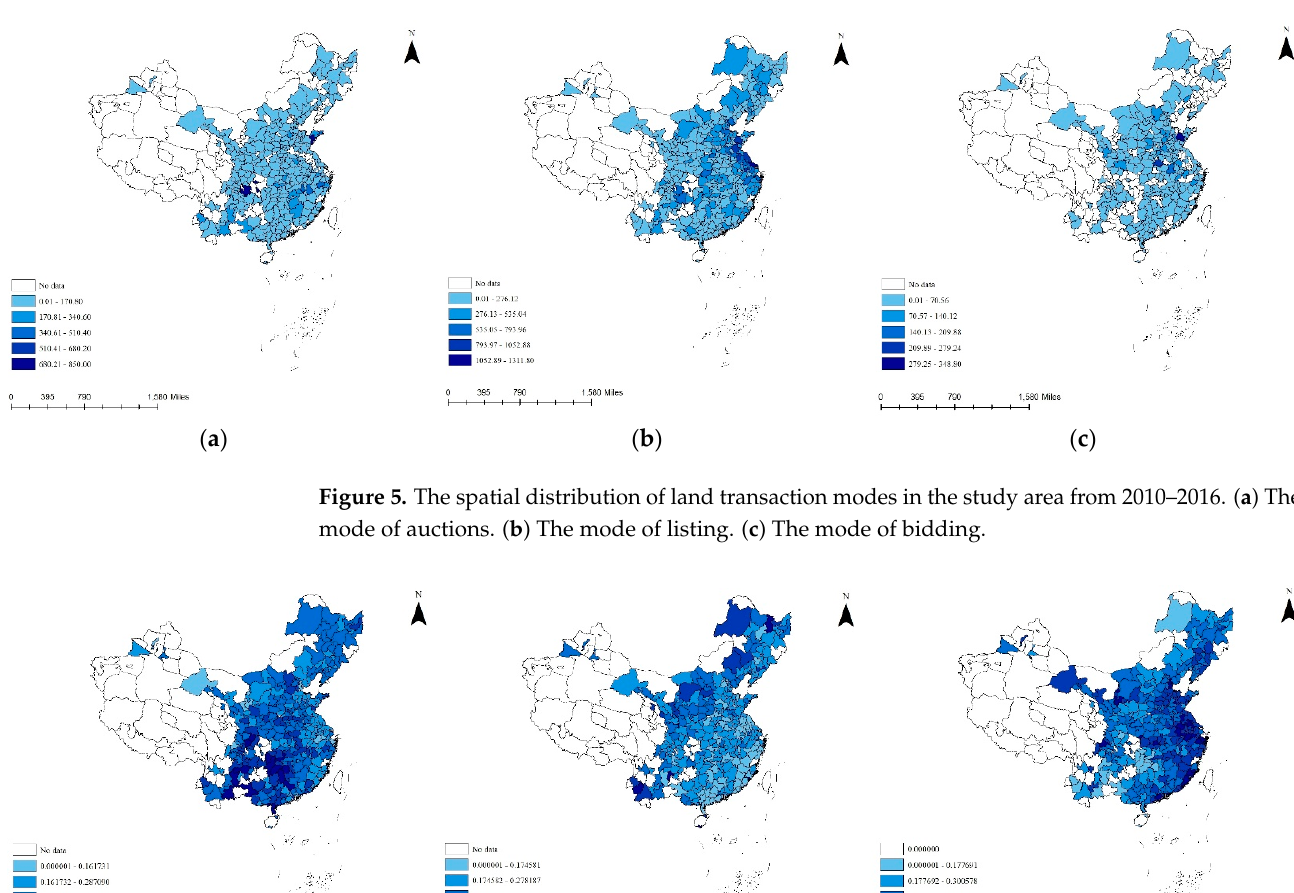
Figure 4. The spatial distribution of land transaction prices in the study area from 2010–2016.